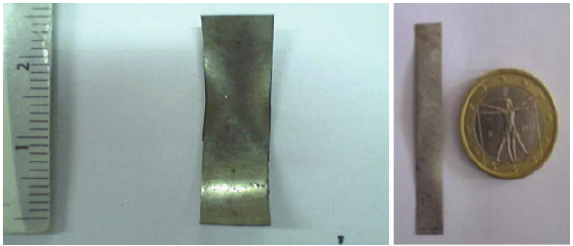
Figure 2: IPMC sample.